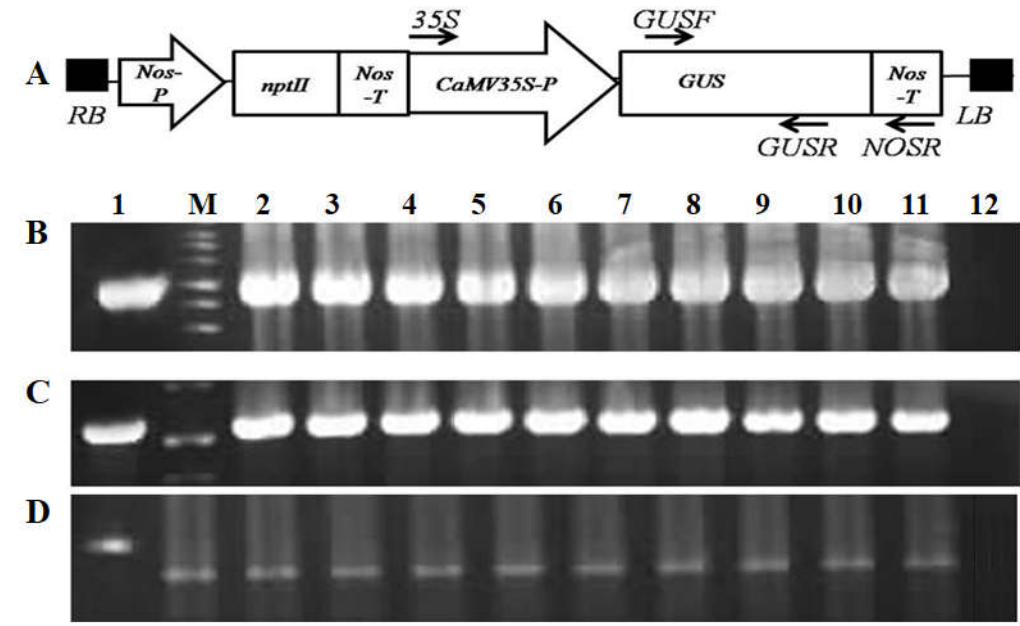
Fig. 3. Molecular analysis of extracted DNA from 10 green plants in the best treatment: A) Schematic figure of primer positions using in PCR and RT-PCR; B) PCR of transformed plants; C) RT-PCR of transformed plants; D) RT-PCR Tubulin housekeeping gene as control; line1= positive control (pBI121 plasmid); line 2-11= PCR products of 35S/NOSR primers and RT-PCR products of GUSF/GUSR primers; line12= PCR and RT-PCR of wild type plant; line M= Molecular Marker